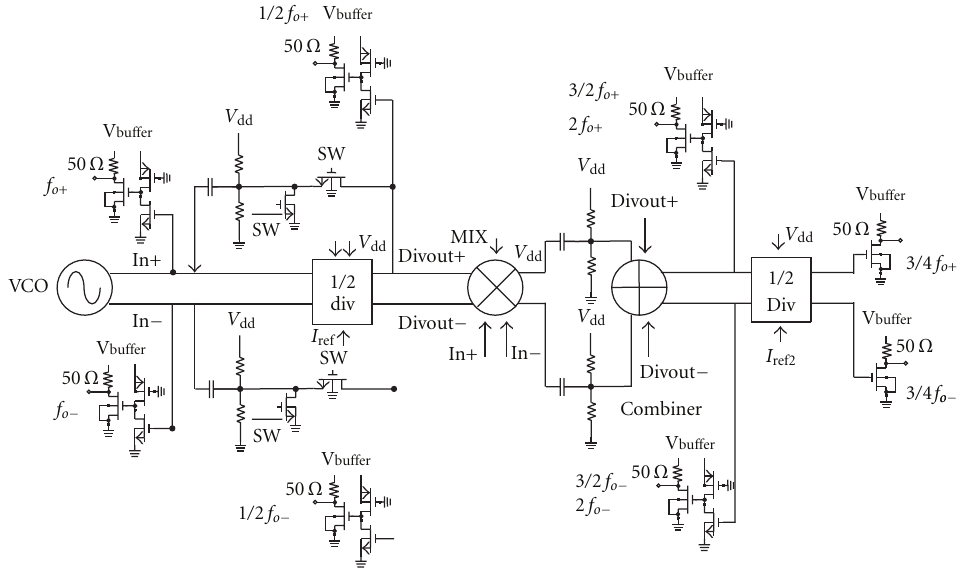
Figure 6: Block diagram of the proposed wideband VCO.